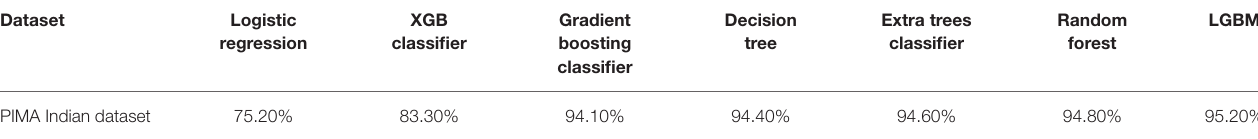
TABLE 1 | Accuracy percentage.